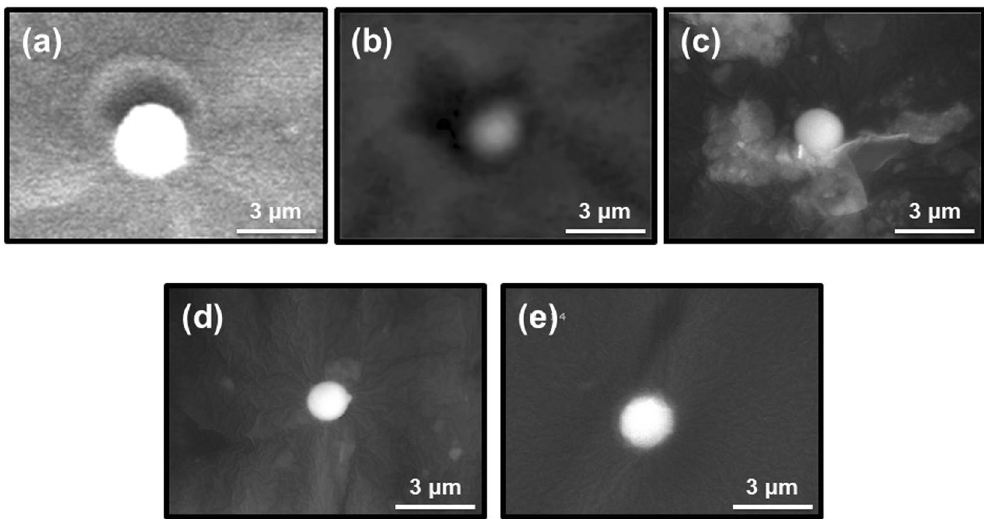
Figure 1. SEM images of five particles separated from the non-woven fabric cloth samples. The particles were placed on Kapton tapes for the SEM-EDS analyses. ( a – e ) SEM images of ( a ) particle A (diameter: 2.7 μ m), ( b ) particle B (1.8 μ m), ( c ) particle C (2.0 μ m), ( d ) particle D (1.6 μ m), and ( e ) particle E (2.1 μ m).